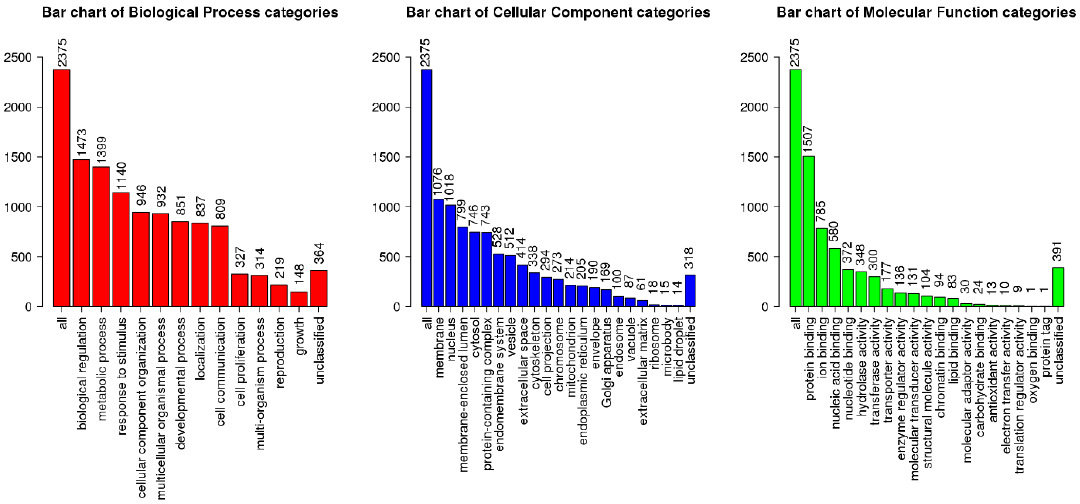
Figure 4 . Most affected biological processes, cellular components, and molecular function categories from GO enrichment terms.